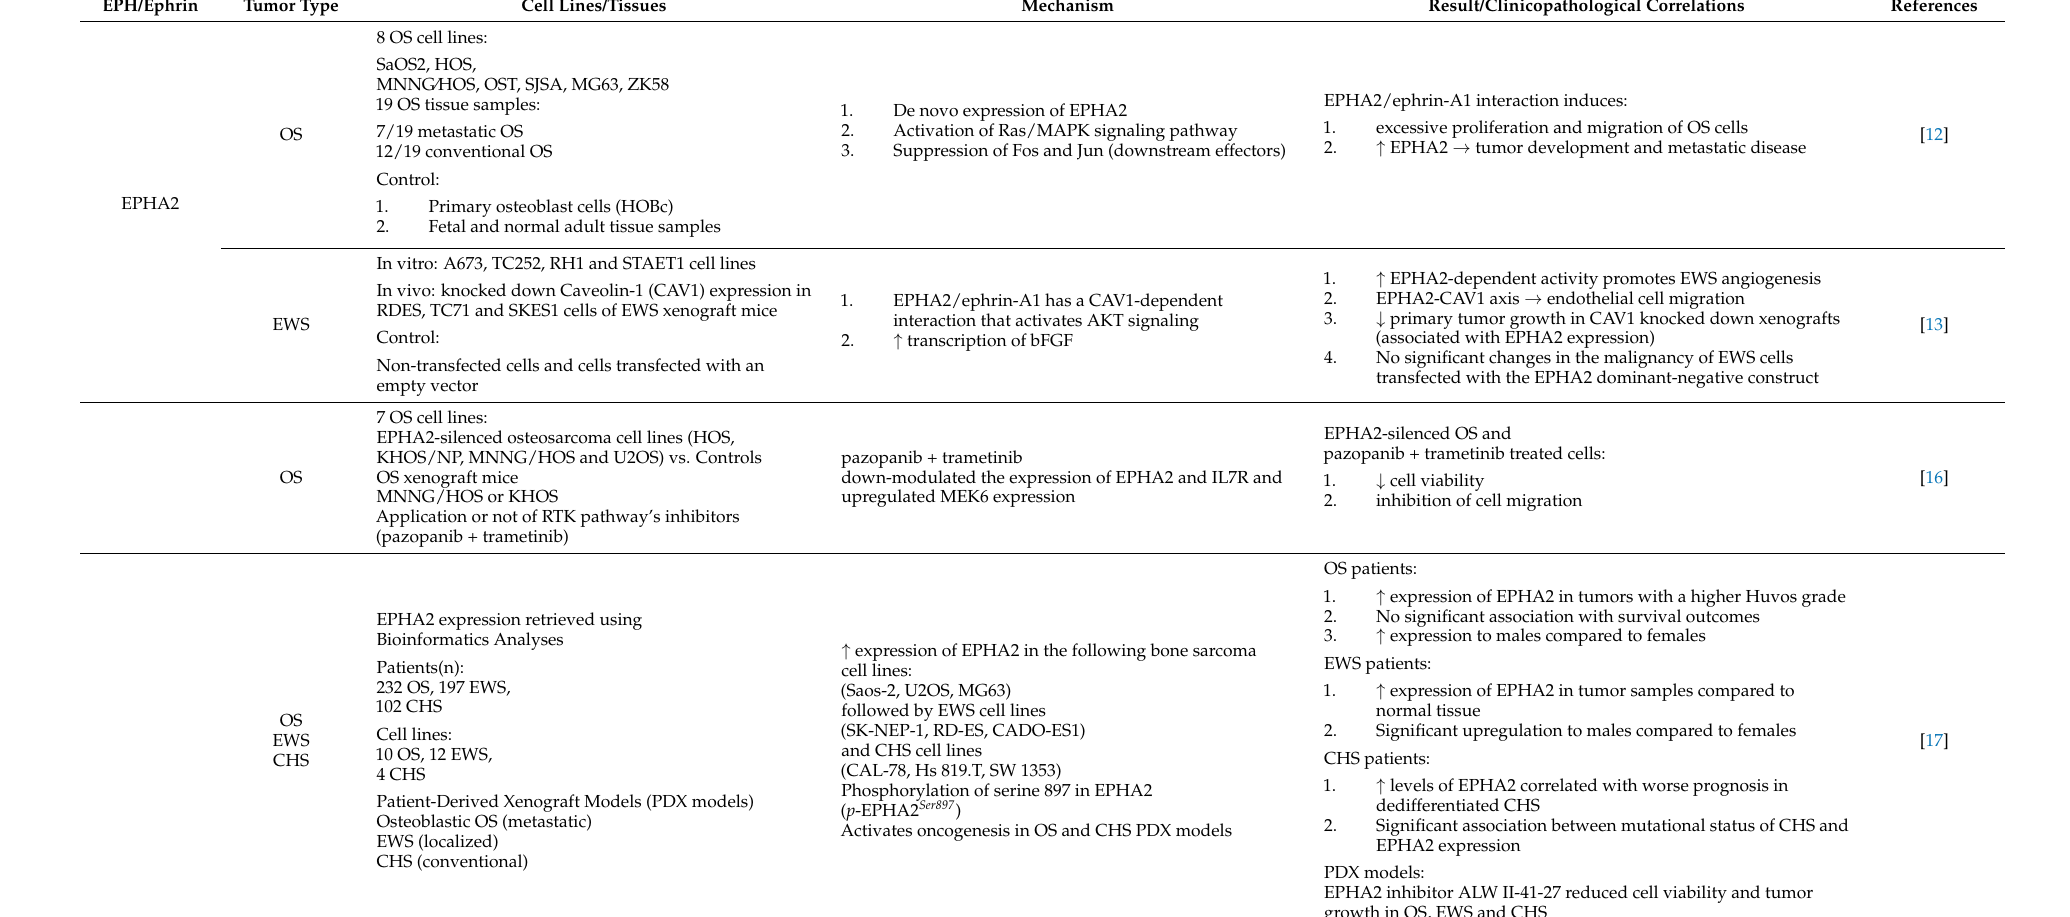
Table 1. Molecular mechanisms involving the EPH/ephrin axis in bone sarcomas leading to specific laboratory and clinicopathological outcomes.